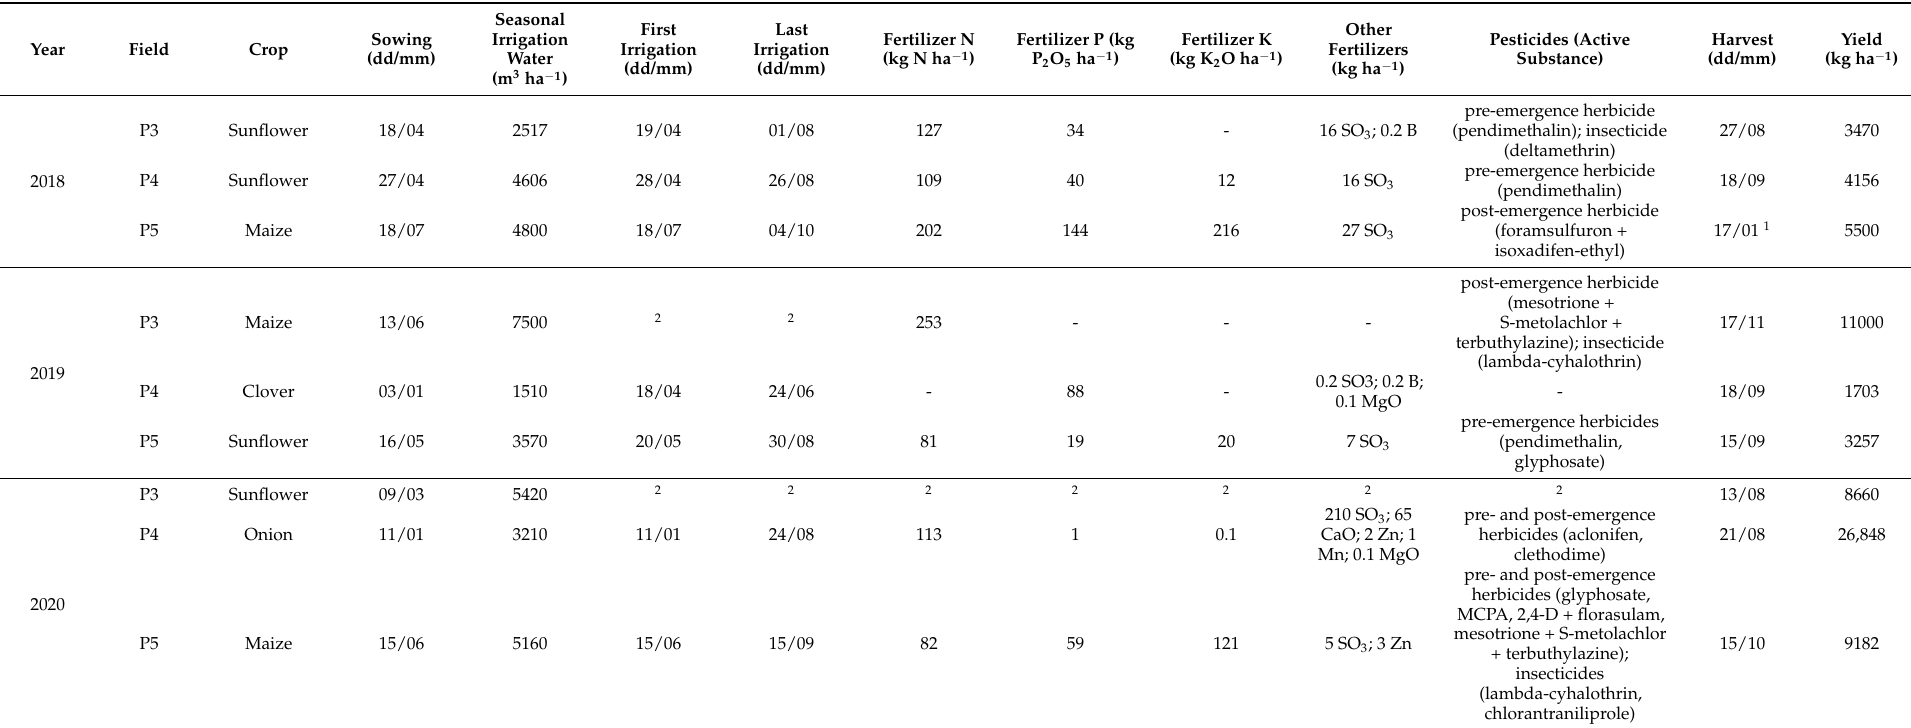
Table 1. Main crop management data in each year (2018 to 2020) and field (P3, P4, and P5) (information provided by the